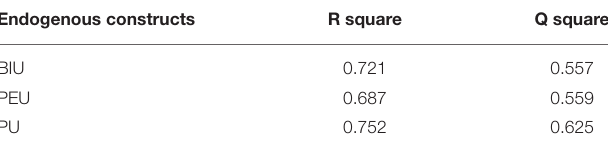
TABLE 11 | Results of R 2 and Q 2 values.